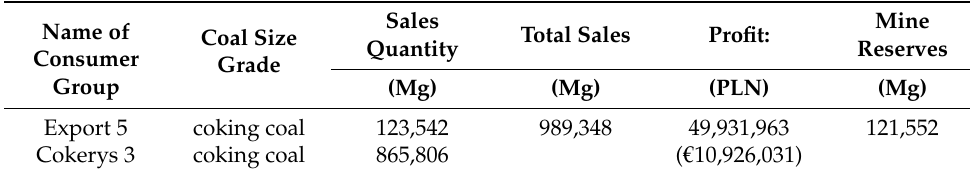
Table A6. The optimal production and sales plan for mine “C” for 2021.